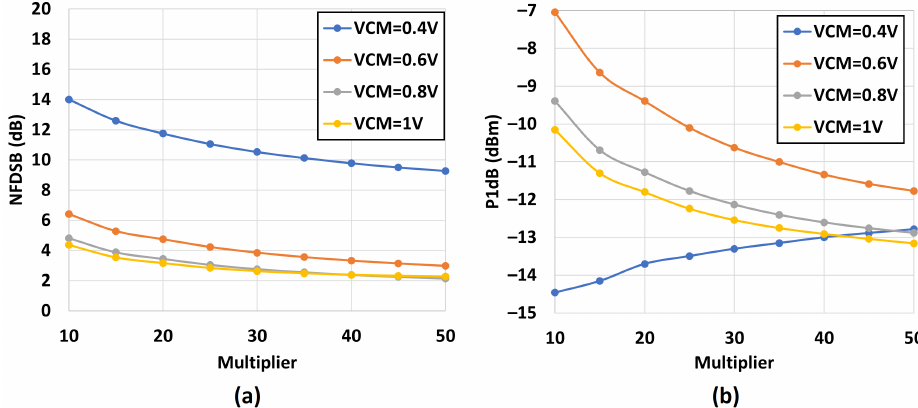
Figure 4. ( a ) The noise figure and ( b ) the 1 dB compression point versus the W/L ratio for different gate voltages of the input